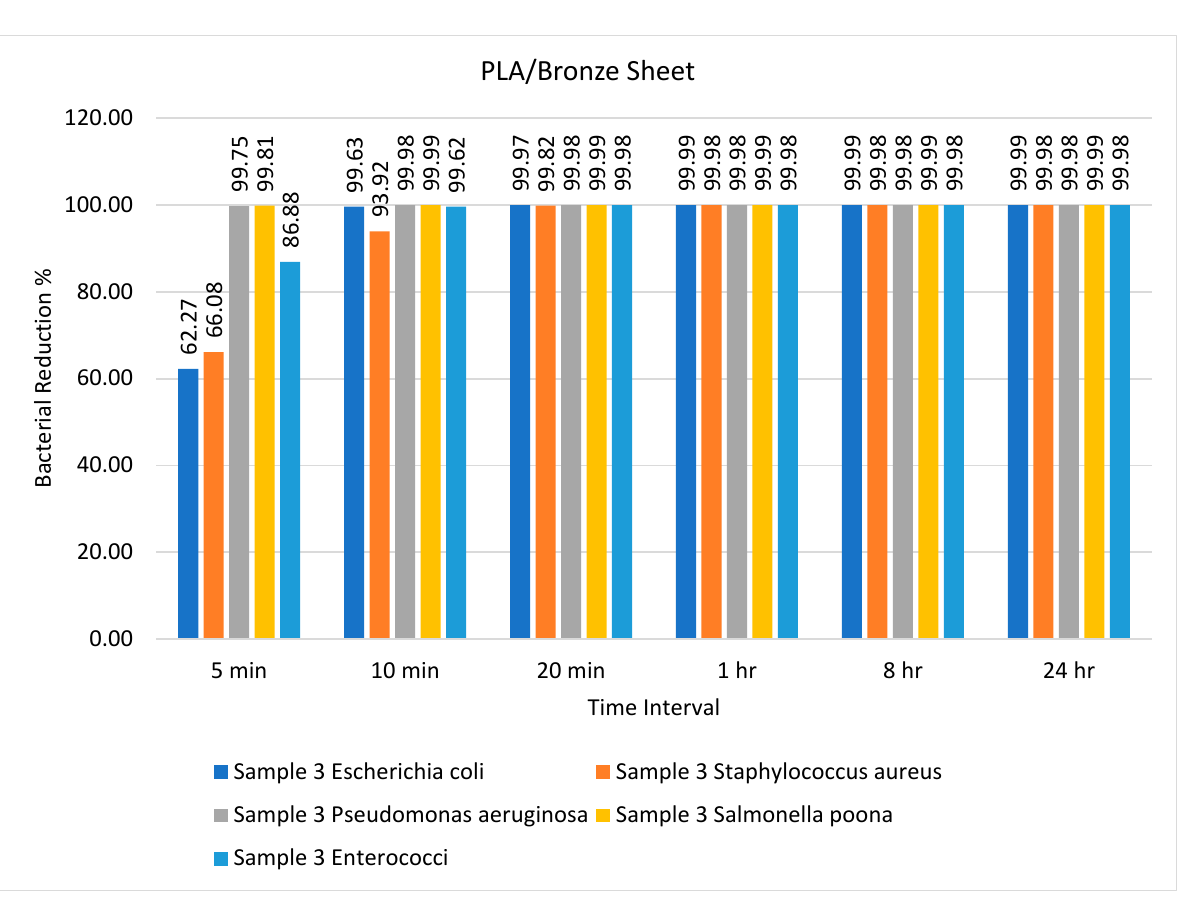
The percentage bacterial reduction for the PLA/bronze sheet is shown in Figure 8. The maximum reductions of 99.75% for Pseudomonas aeruginosa and 99.81% for Salmonella poona were achieved after just 5 min. Pandey et al. [92] utilized mesoporous Ag/Sn–SnO 2 composite nanoparticles as an antimicrobial agent against E. coli and Pseudomonas aeru- ginosa and successfully inhibited bacterial growth. Comparable results were presented by Nong et al. [93], who used a metal–organic framework-based nanozyme hybrid material as an antimicrobial agent against Escherichia coli and Staphylococcus aureus .